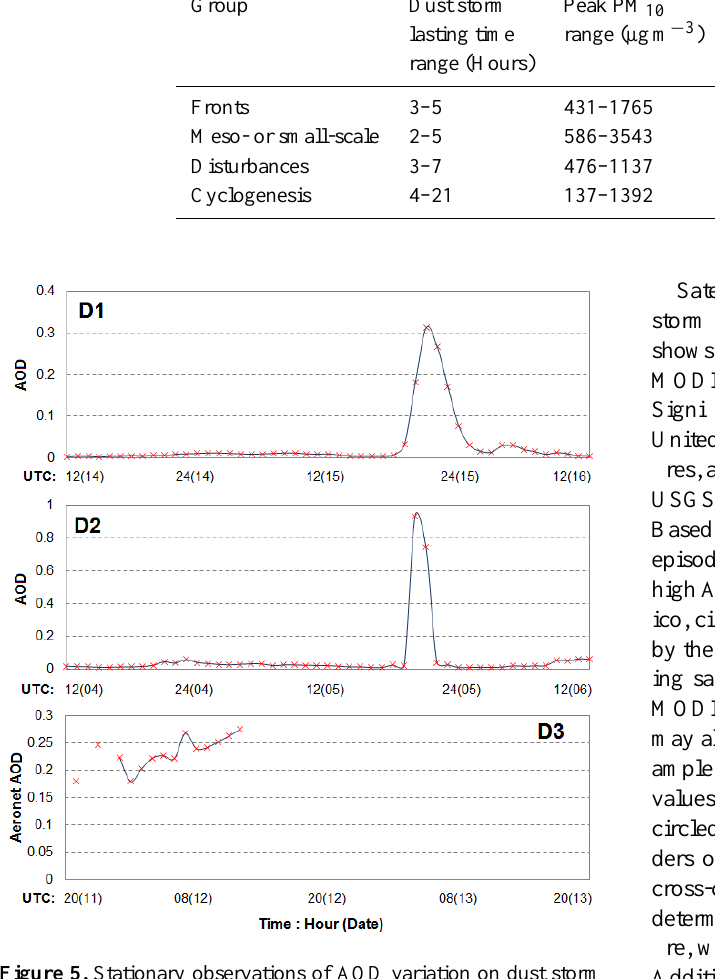
Figure 5. Stationary observations of AOD variation on dust storm day from sites within the dust storm influencing region. D1: from IMPROVE nephelometer (530nm) monitor on site BIBE1; D2: from IMPROVE nephelometer (530nm) monitor on site DYRT1; D3: 500nm AOD from AERONET monitor on site La_Jolla. No stationary AOD measurements available for